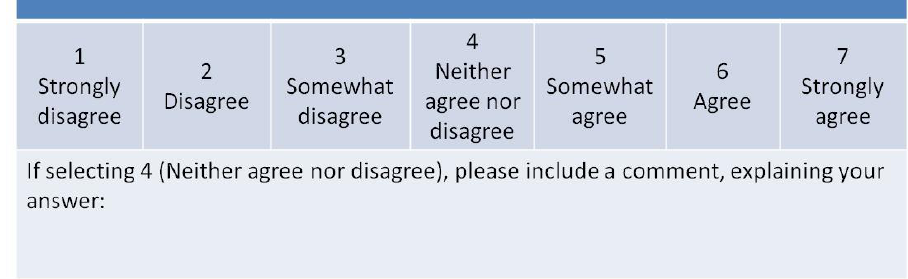
Figure 2. The scoring system, employing a 7-point